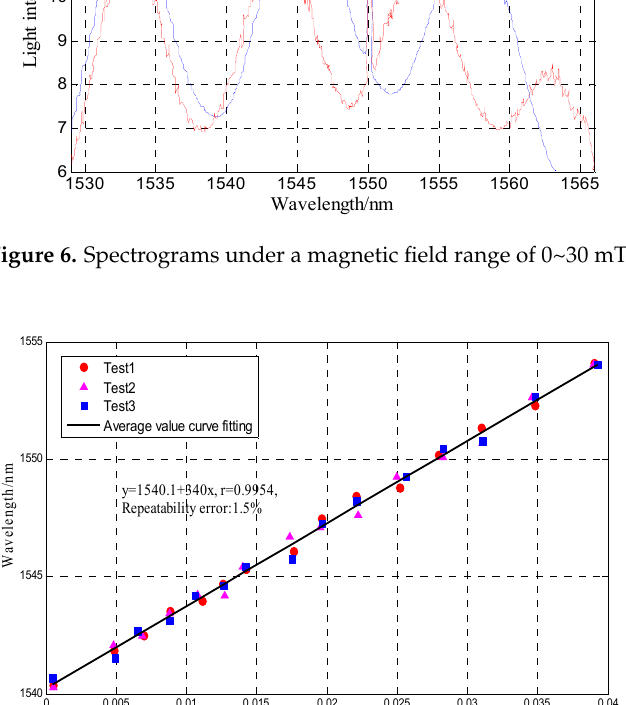
Figure 7. FP peak wavelength variation versus magnetic field.